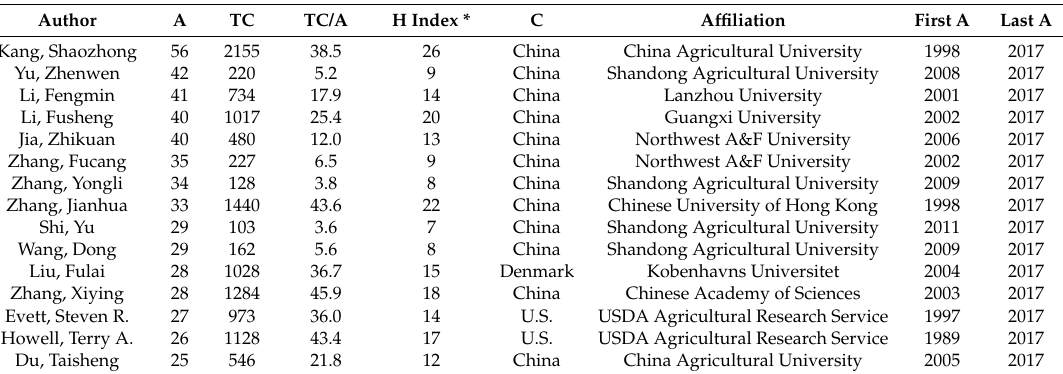
Table 6. Most productive authors in WUEA research for 1988–2017.